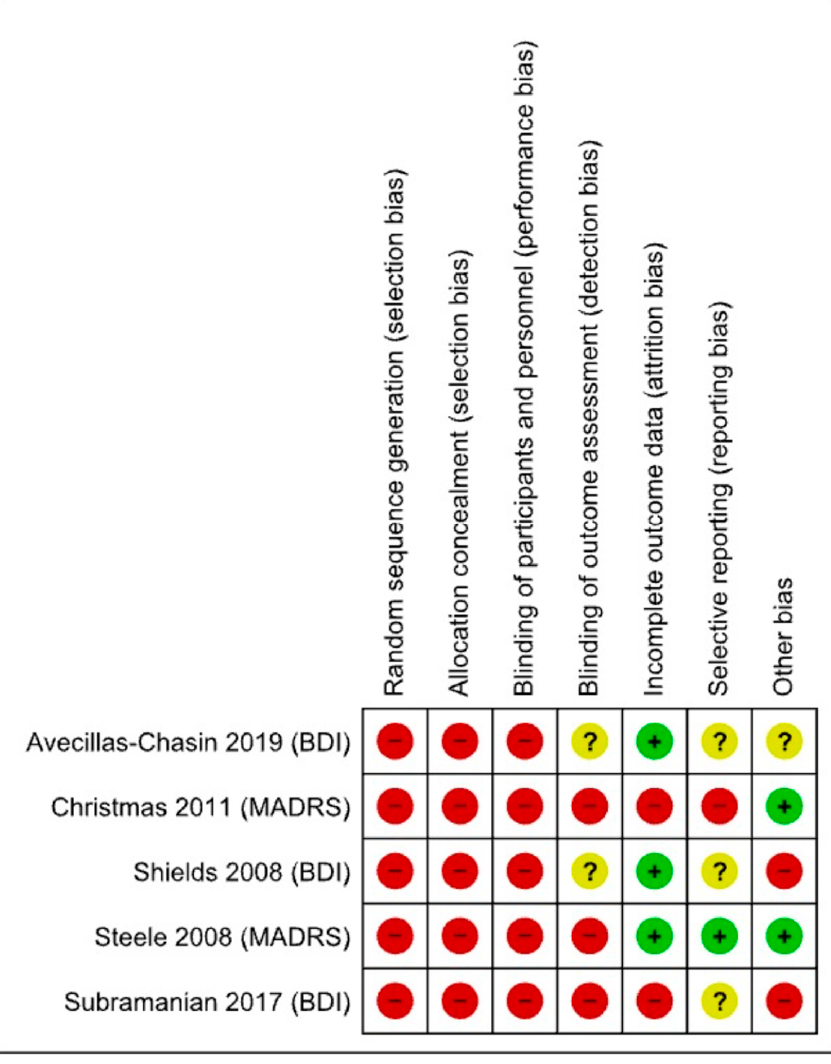
Figure 3. Risk of bias summary for included studies, using the Cochrane risk of bias tool. Red = High risk; Green = Low risk; Yellow = Unclear. [10,18–21].